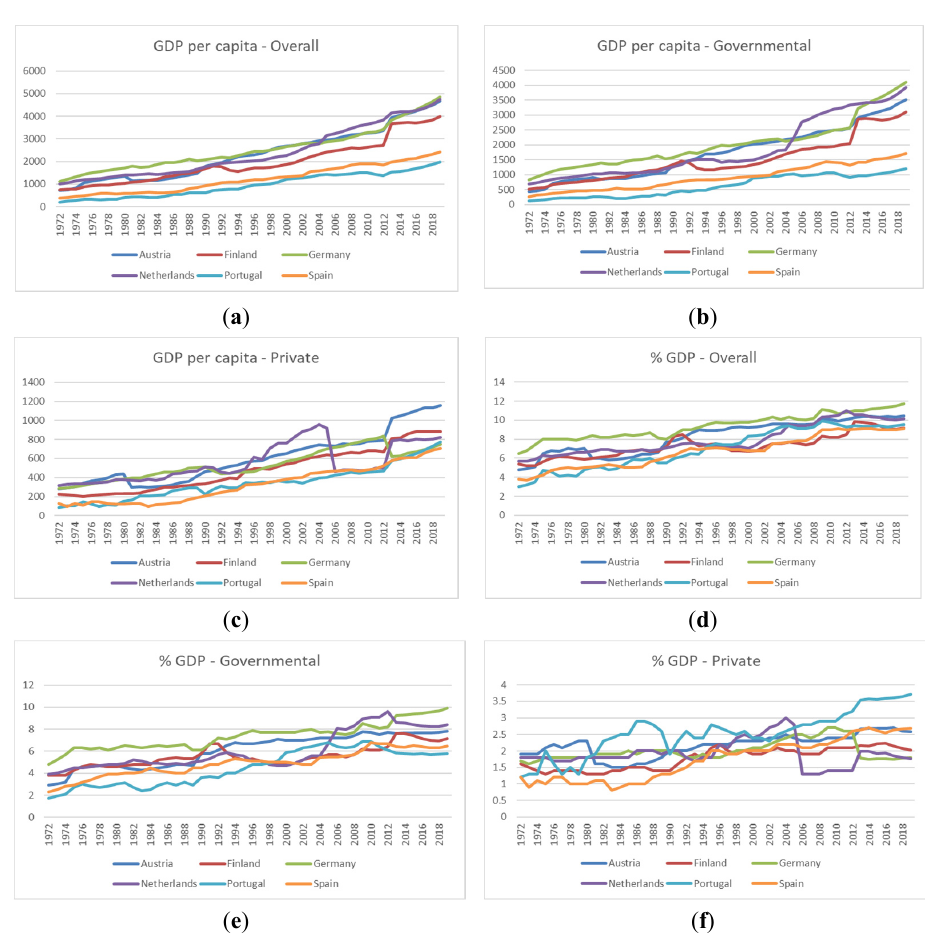
Figure 1. Health-expenditure-to-GDP ratio and health expenditure as % in GDP in selected countries. Source: OECD statistics.